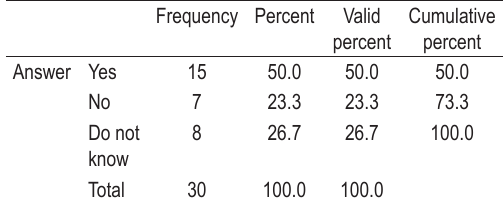
Table 2. Level of information concerning the specificities of warfarin use, provided by health care